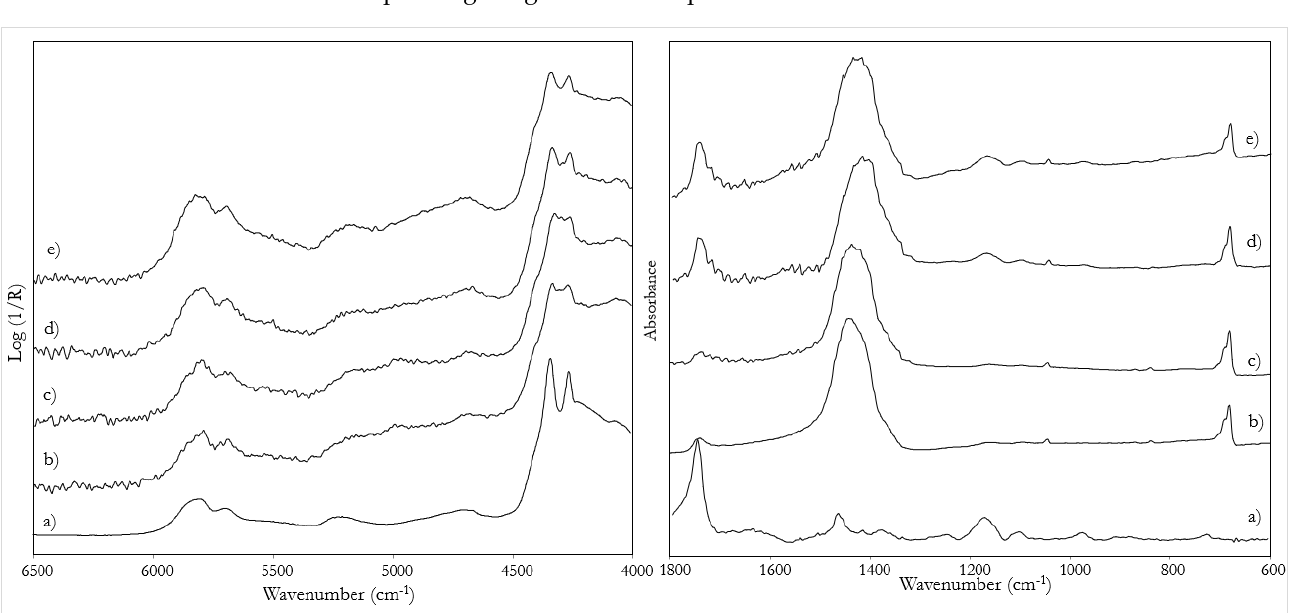
Figure 3. NIR ( left ) and MIR ( right ) spectra of: ( a ) linseed oil, ( b ) white priming layer, ( c ) pink priming layer, ( d ) lead white in linseed oil on white priming layer, ( e ) lead white in linseed oil on pink priming layer. All spectra of reference materials and model painting samples were acquired in reflection mode.